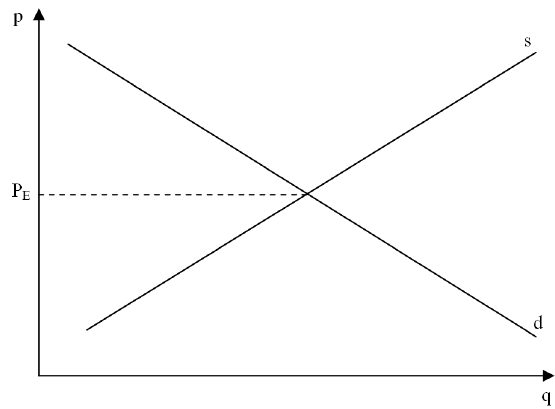
Figure 1. Equilibrium